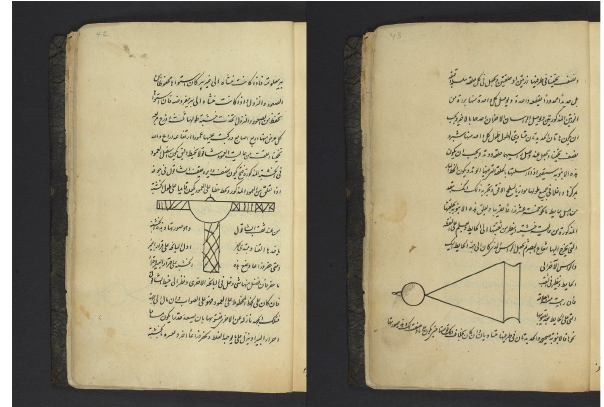
Figure 7. Illustrations for the apparatus and to describe how to measure and determine the height of a mountain. Dia- grams f37v and f40v from Karaji (1675). Permanent link: http://hdl. library.upenn.edu/1017/d/medren/9948256513503681 (last access: 29 July 2019).